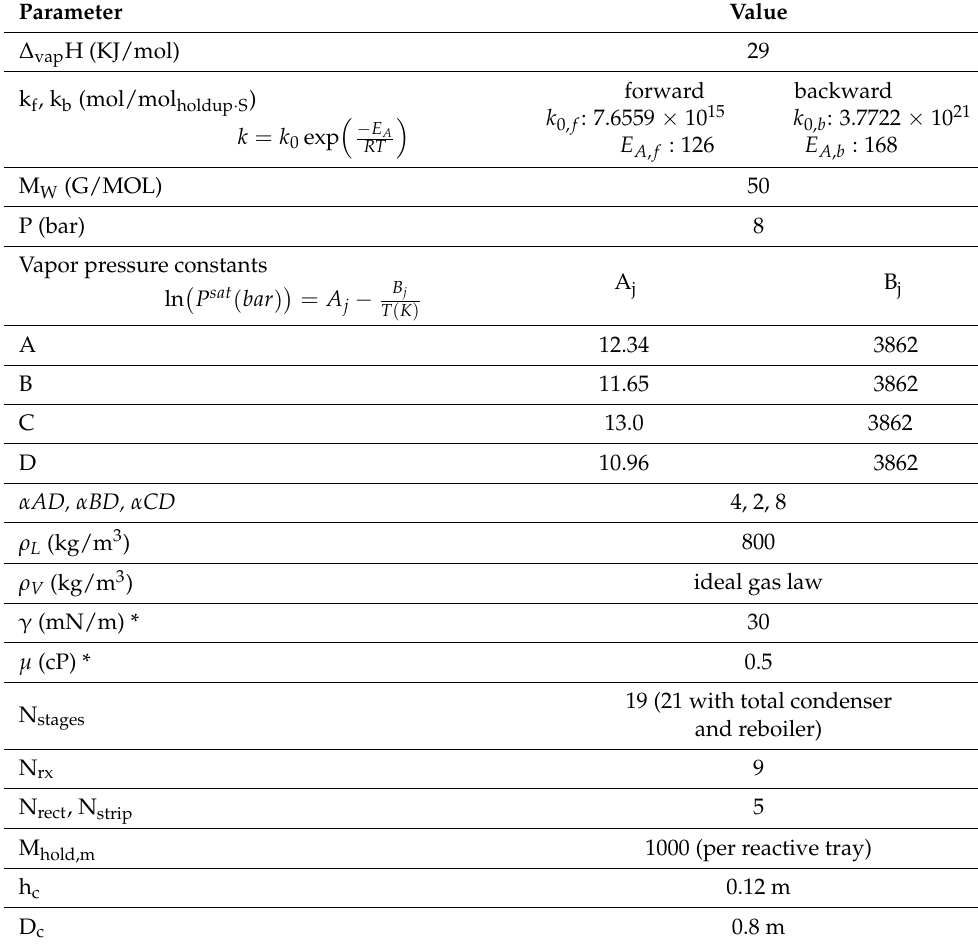
Table 1. Physiochemical and design parameters of the reference case, parameter values adapted from Luyben [12]. *Added in this work for the tray hydraulic